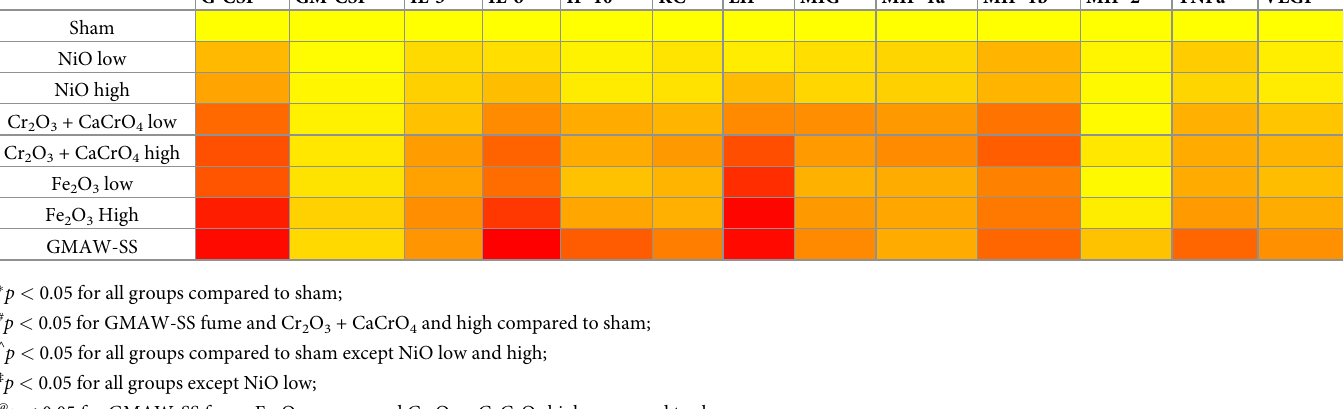
Table 3. BAL cytokine analysis at 1 day post-exposure to GMAW-SS fume or surrogate metal oxides. Color scheme of yellow-orange-red represent fold change from sham (darker red represents greatest change). G-CSF � Sham